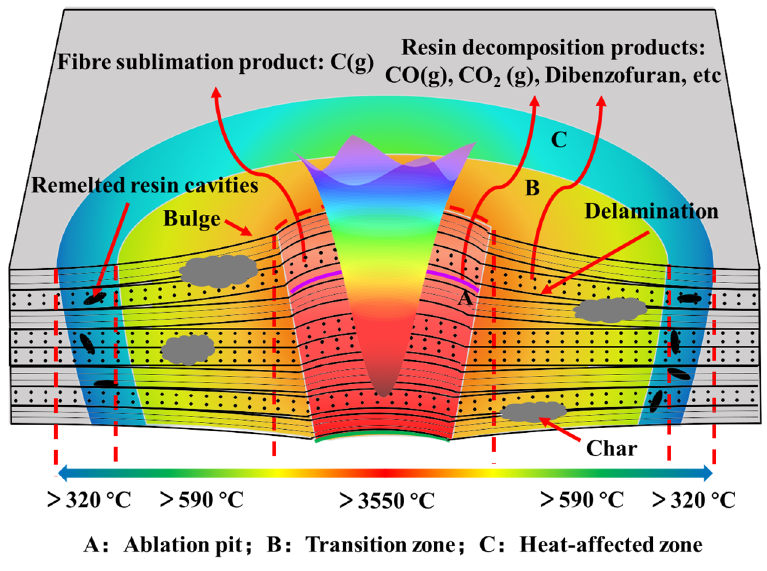
Figure 7. Schematic of the ablation mechanism of CF/PAEK. When a high-energy CW laser irradiates the surface of the CF/PAEK laminate, the temperature in the spot center increases rapidly, causing the PAEK resin and the CFs to decompose and sublimate instantly. According to the temperature distribution, the ablation area can be divided into three regions: ablation center, transition zone, and heat-affected zone. The ablation center is directly irradiated by the laser, showing the fastest heating rate and the highest temperature (i.e., >3550 ◦ C). The PAEK resin first decomposes to produce small molecular gaseous products. When the temperature continues to rise above the sublimation temperature of the CF, the CFs sublimate into gas. Since the laser energy has a Gaussian distribution, a V-shaped ablation pit is formed. Due to the rapid formation of abundant gaseous products, a positive vapor pressure is formed, which prevents external air from entering the ablation pit. Therefore, the PAEK resin decomposes and leaves a thin residual carbon layer on the surface of CFs. Meanwhile, the CFs sublimates and forms a needle-like structure owing to the inhomogeneity of the fibers along the radial